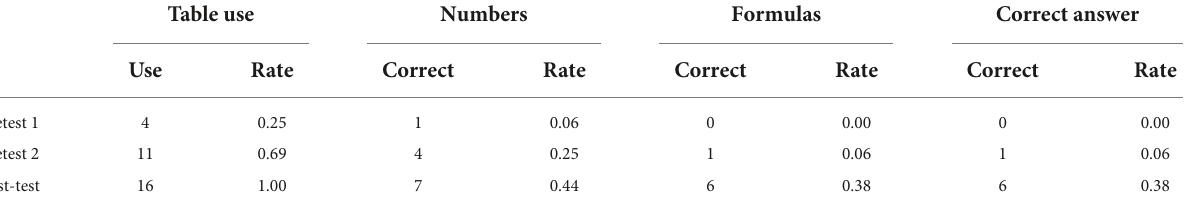
TABLE 4 Table use, numbers, formulas, and correct answer.